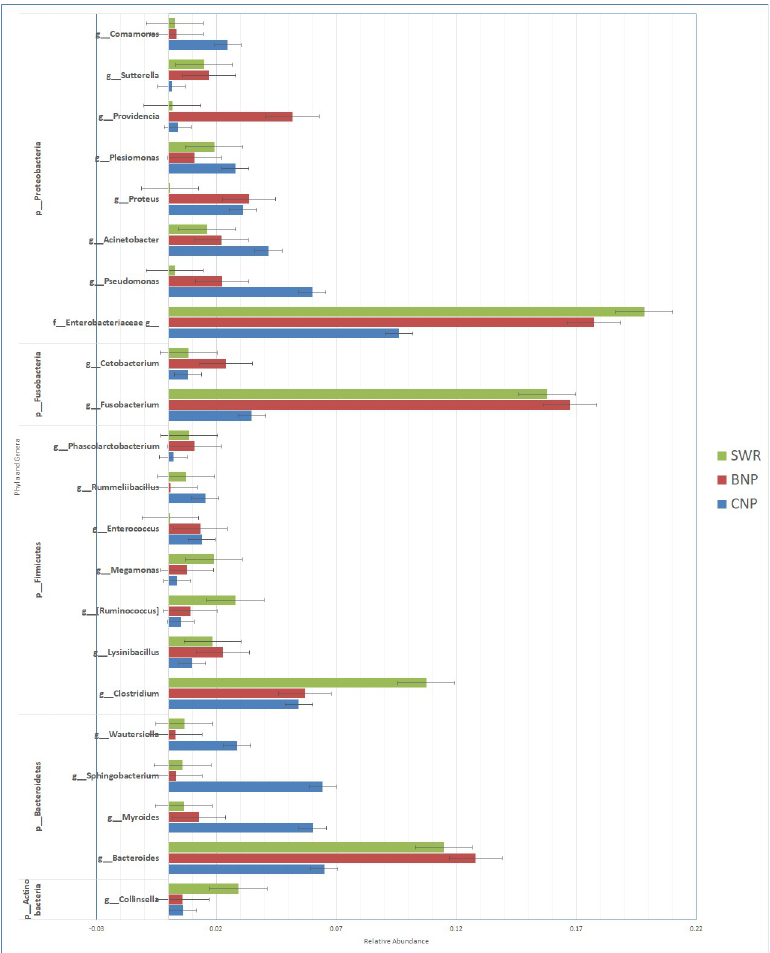
Fig 3. Gut microbiota diversity in tiger populations of Nepal. Relative abundance of top five microbial phyla and their subsequent genera identified in tiger fecal samples collected across three protected areas (CNP, BNP, SWR) within TAL.